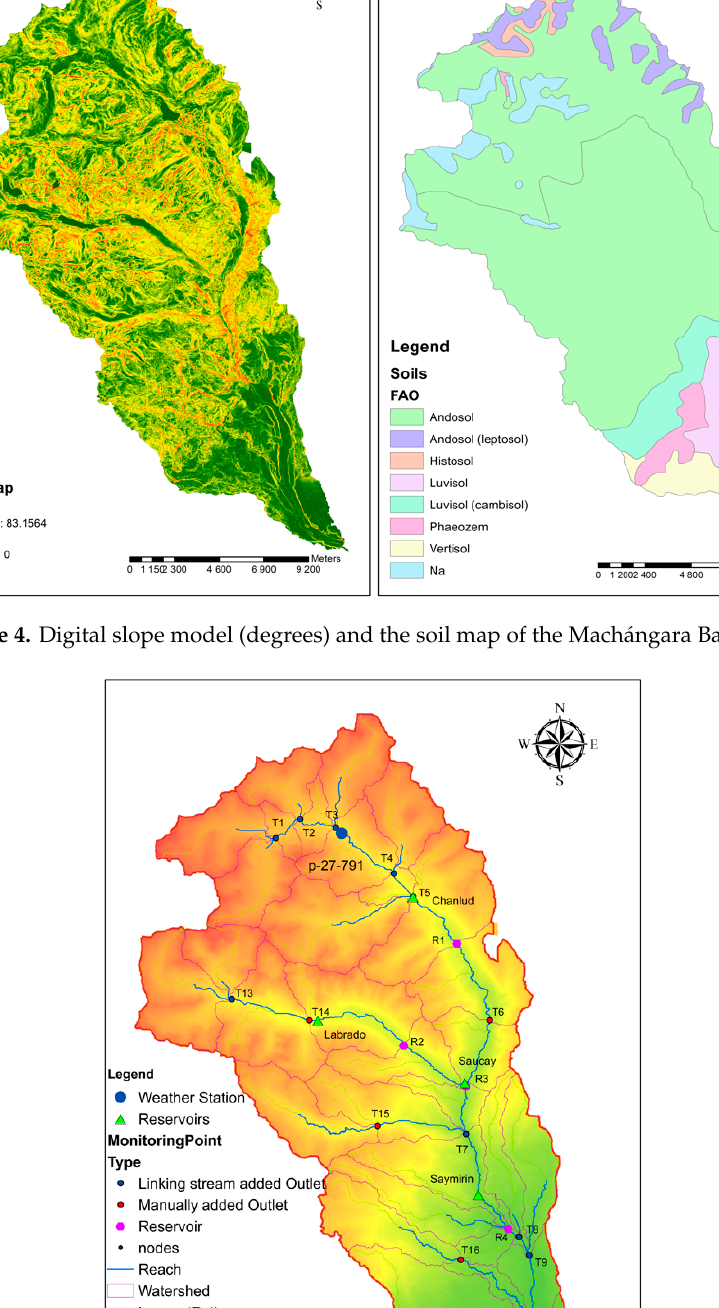
Figure 6. Simulated water inflow in the Machángara River system at transfer node T1. 2.2.3. Water Demand and Final River Network Configuration The network configuration resulting from the previous step consists of 16 transfer (T), 4 reservoir (R) nodes and 19 river segments. This preliminary network is to be extended with demand nodes (D)